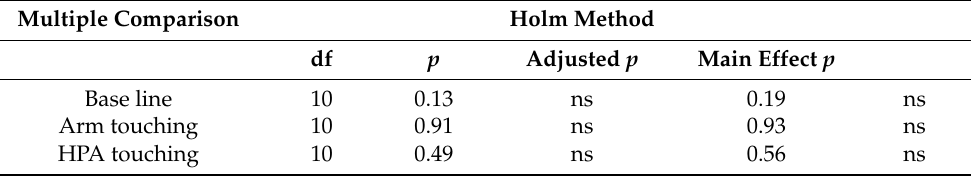
Table 6. The result of multiple comparison of heart rate of the trauma group.